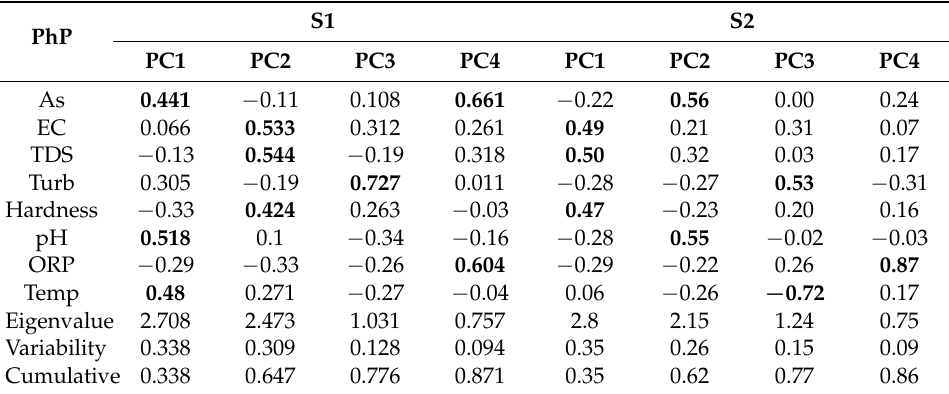
Table 5. Eigenvectors and eigenvalues of the PhP.